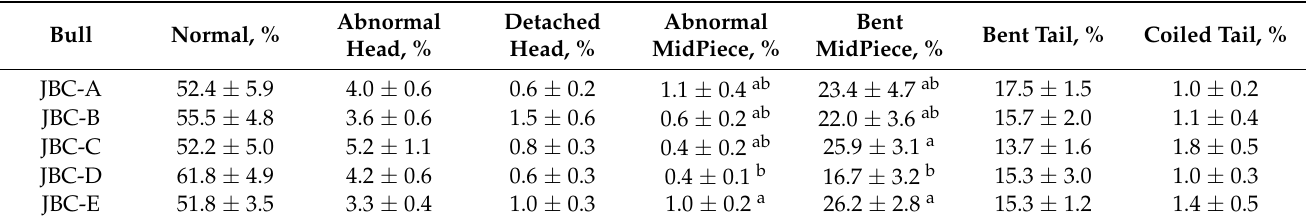
Table 5. Morphology of frozen–thawed 7 cm sperm from individual JBC bulls, as assessed by Diff-Quik